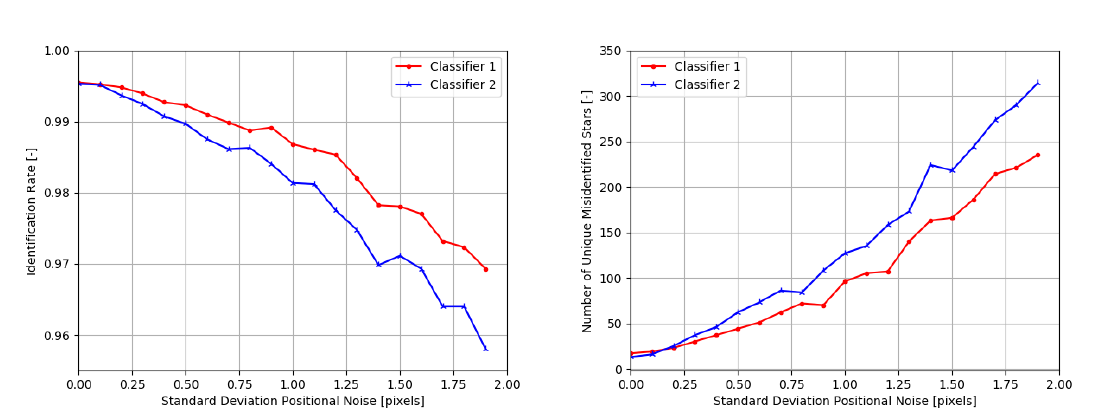
Figure 6. Identification rate under influence of positional